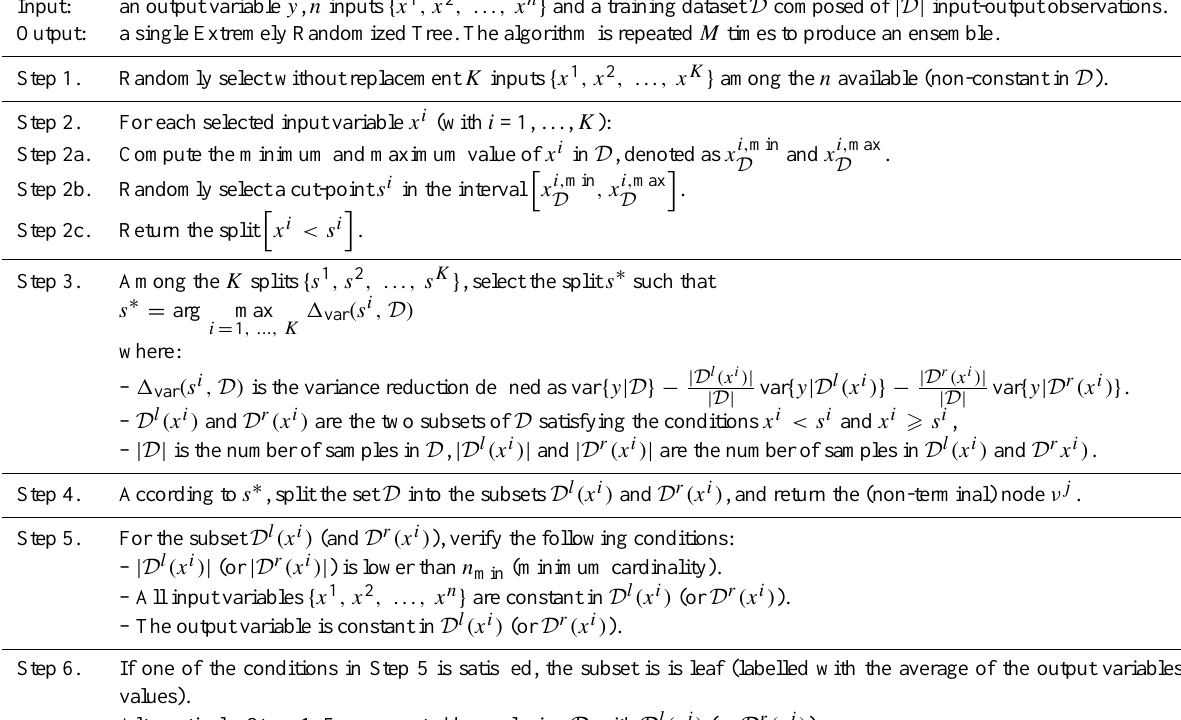
Table 1. Tabular version of the Extra-Trees building